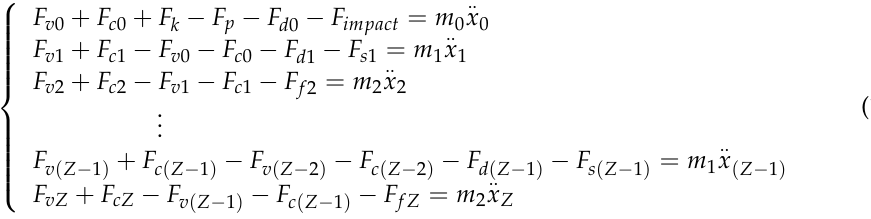
sively numbered as 0, 1, 2, 3, …, Z − 1, and Z from the piston to the final friction disc. The